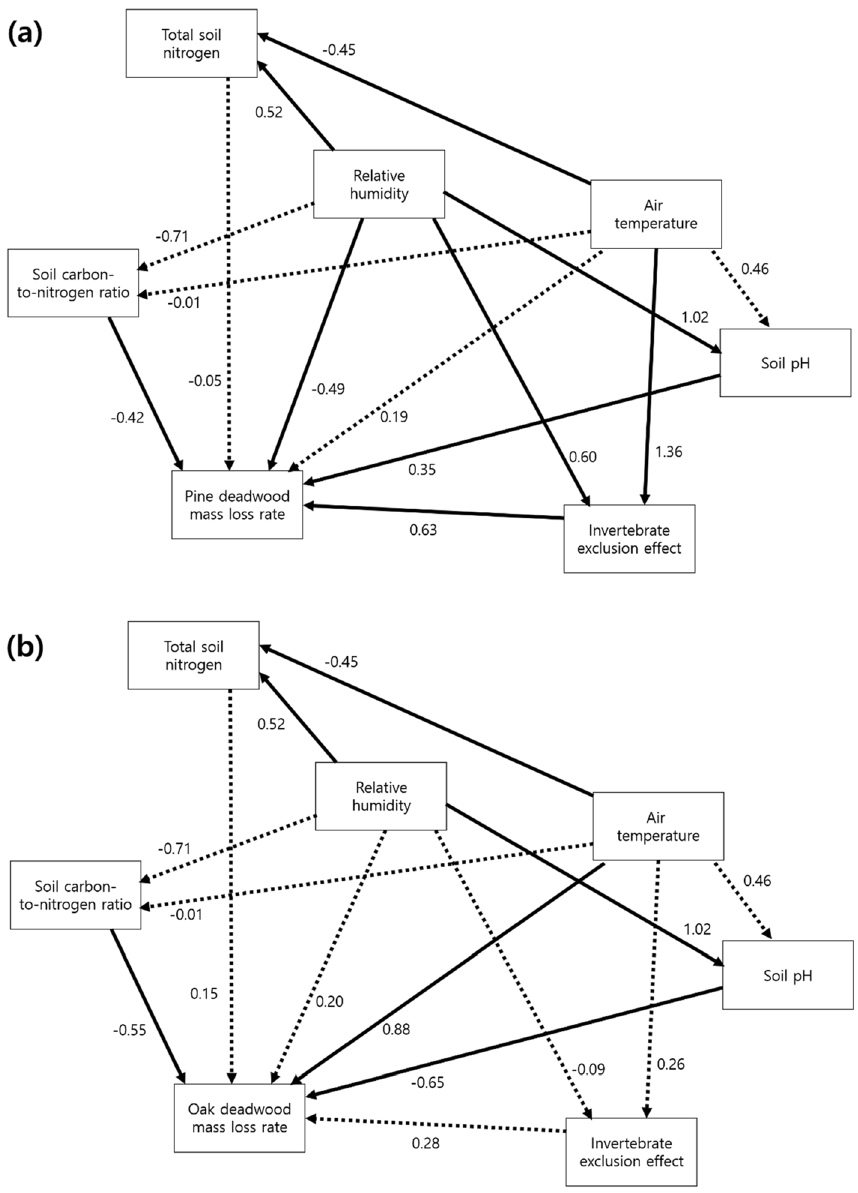
Figure 4. Results of structural equation models for the mass loss of pine ( a ) and oak ( b ) deadwoods. Values next to each arrow show path coefficients. Straight and dashed arrows indicate significant and non-significant effects at P <